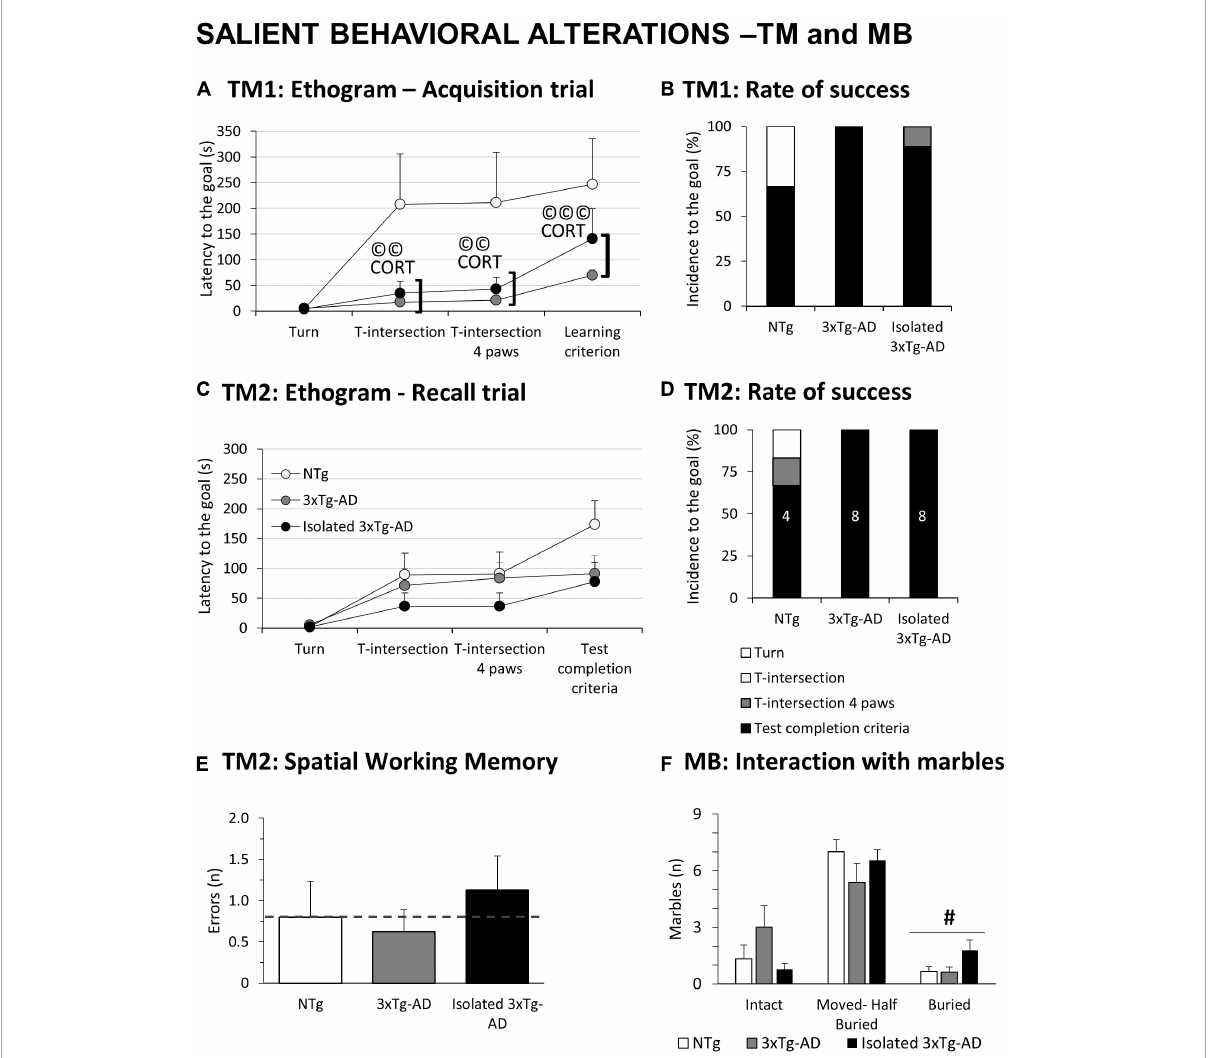
FIGURE2 Salient behavioral alterations in 18-month-old female 3xTg-AD females in the T-maze and marble test compared to NTg females with normal aging. Results are expressed as mean ± SEM or incidence (%). (A) Ethogram in the acquisition trial (TM1) in the T-Maze; (B) rate of success in TM1; (C) ethogram in the recall trial (TM2) in the T-Maze; (D) rate of success in TM2; (E) spatial Working memory in TM2; (F) MB: Marble test, Interaction with marbles. Inset of bars, number of animals exhibiting the behavior. Statistics: Students t -test: # , isolation effect, # p < 0.05. Pearson’s correlation analysis, ©© p < 0.01; ©© p < 0.001; CORT: corticosterone